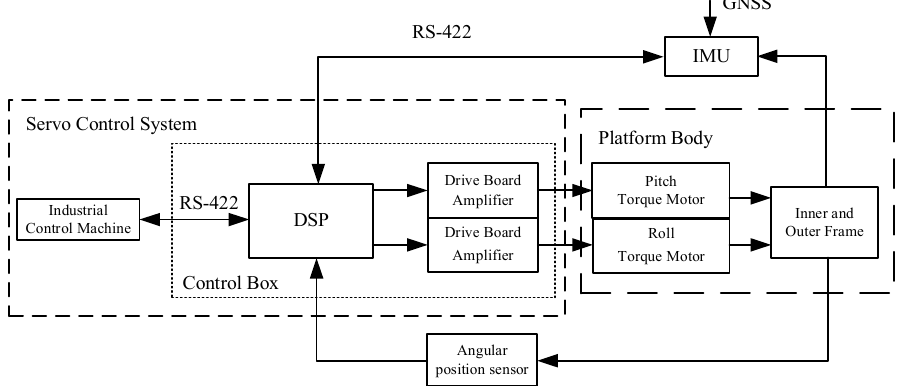
(5) When the control result satis fi es Equation (5), the gravimetric stabilization platform table surface will remain parallel to the local geographical level. 2.3. Control System Block Diagram The servo control system is the core of the gravimetric stabilization platform. Addi- tionally, it ensures algorithm implementation and platform stability accuracy, so a scien- ti fi c and reasonable control system structure is essential. The gravity measurement stable